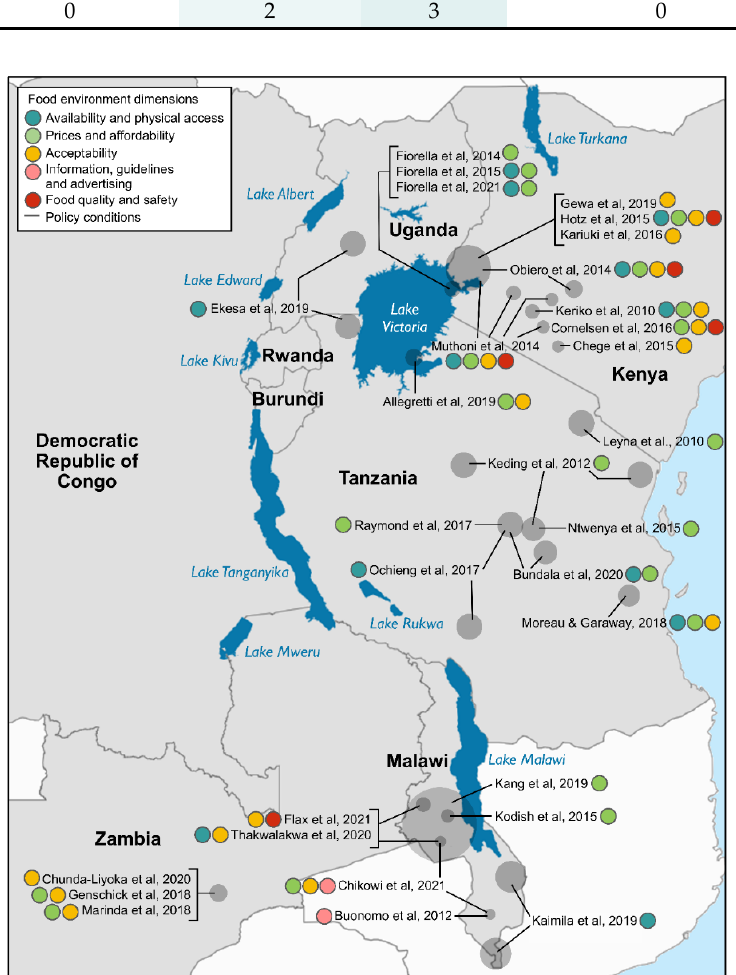
Figure 3. Map of the African Great Lakes Region showing the approximate location of studies in this review which report on factors influencing fish acquisition and consumption. Colours indicate different dimensions of the food environment.